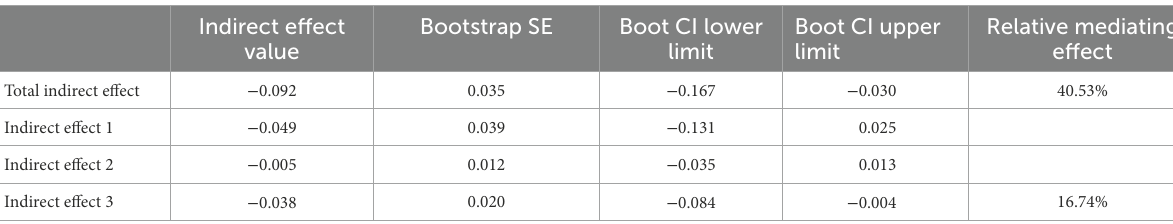
TABLE 3 Analysis of intermediary